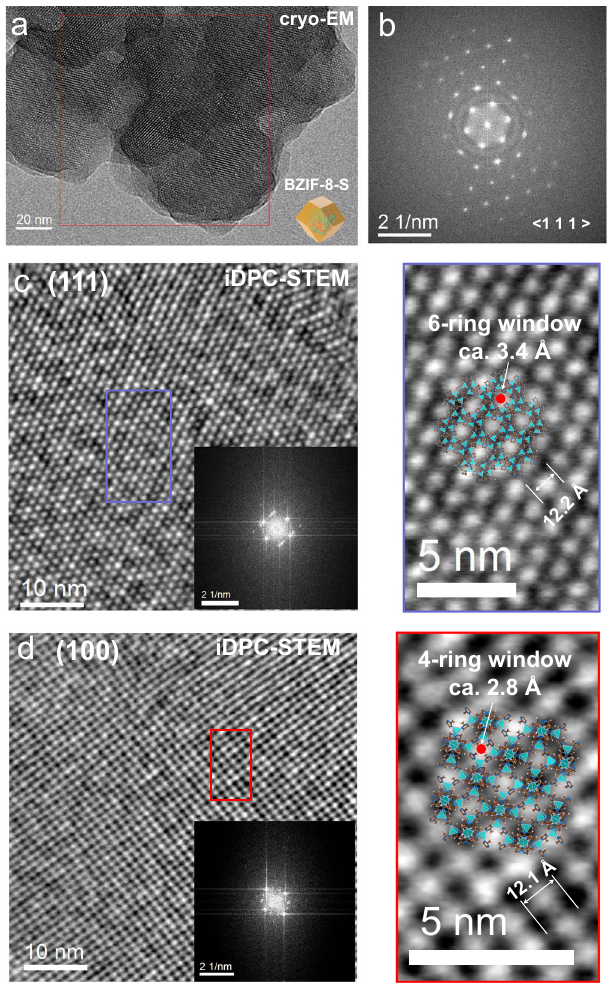
Fig. 2 High-resolution structure imaging of BZIF-8-S. a The cryo-EM structure of BZIF-8-S. b The fast Fourier transform pattern of the selected area in ( a ). The iDPC-STEM image of BZIF-8-S from the [111] projection ( c ) and the [100] projection d in the overfocal imaging mode, and the structural analysis of the selected area. The insert was the FFT pattern from the corresponding